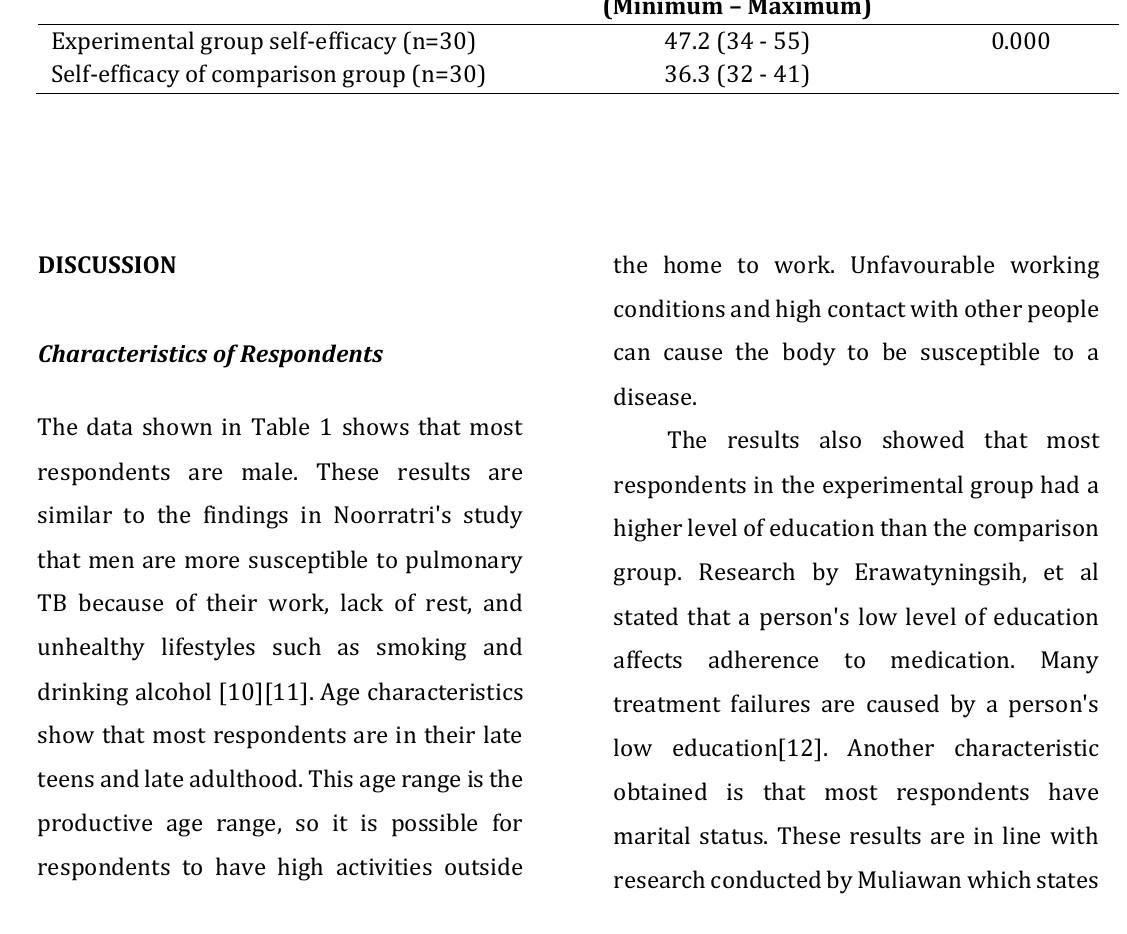
Differences in the Effect of RIMA Therapy and Counseling on Self-Efficacy of Pulmonary TB Patients Experimental group self-efficacy